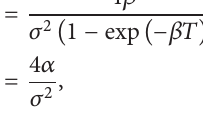
where the subscript denotes the random variable